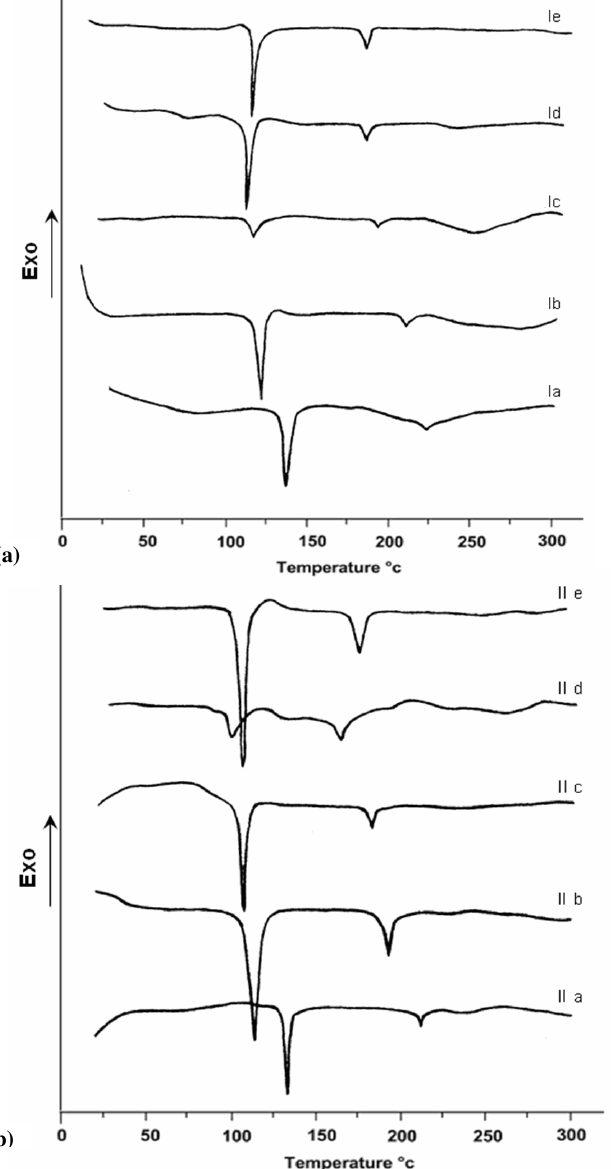
Figure 2 .(a) DSC Thermograms of compounds Ia-e (b) DSC Thermograms of compounds